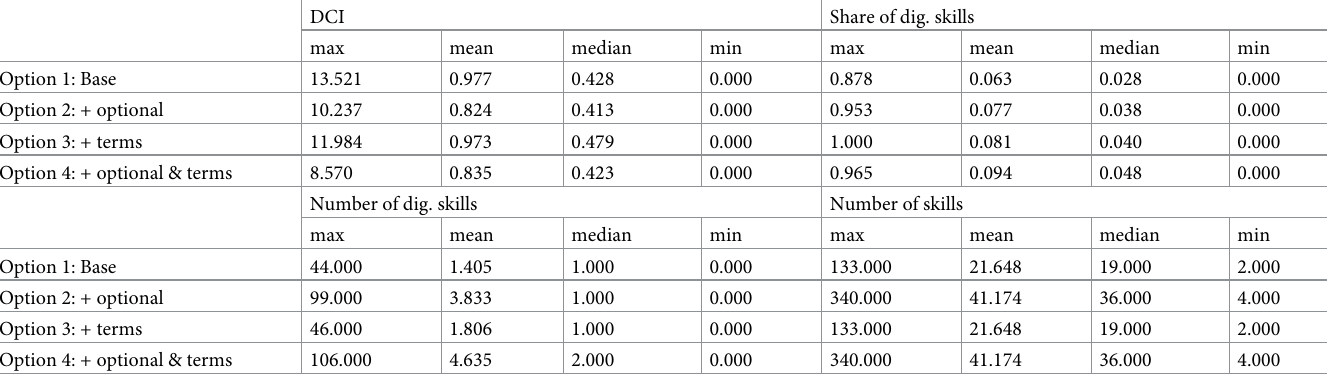
Table 5. DCI versions: Means, medians, maximum and minimum values across